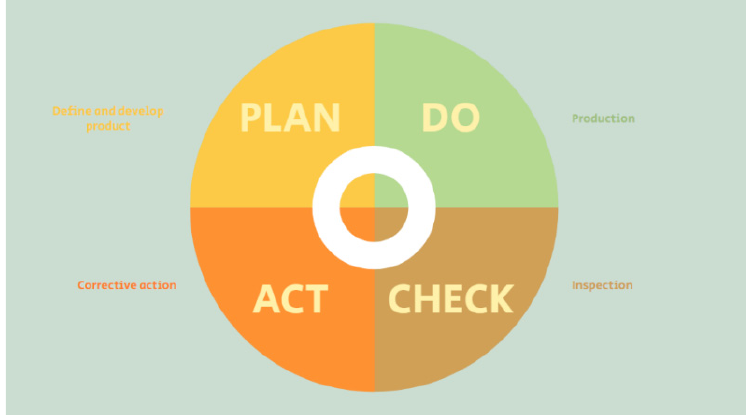
Figure 1. PDCA cycle.